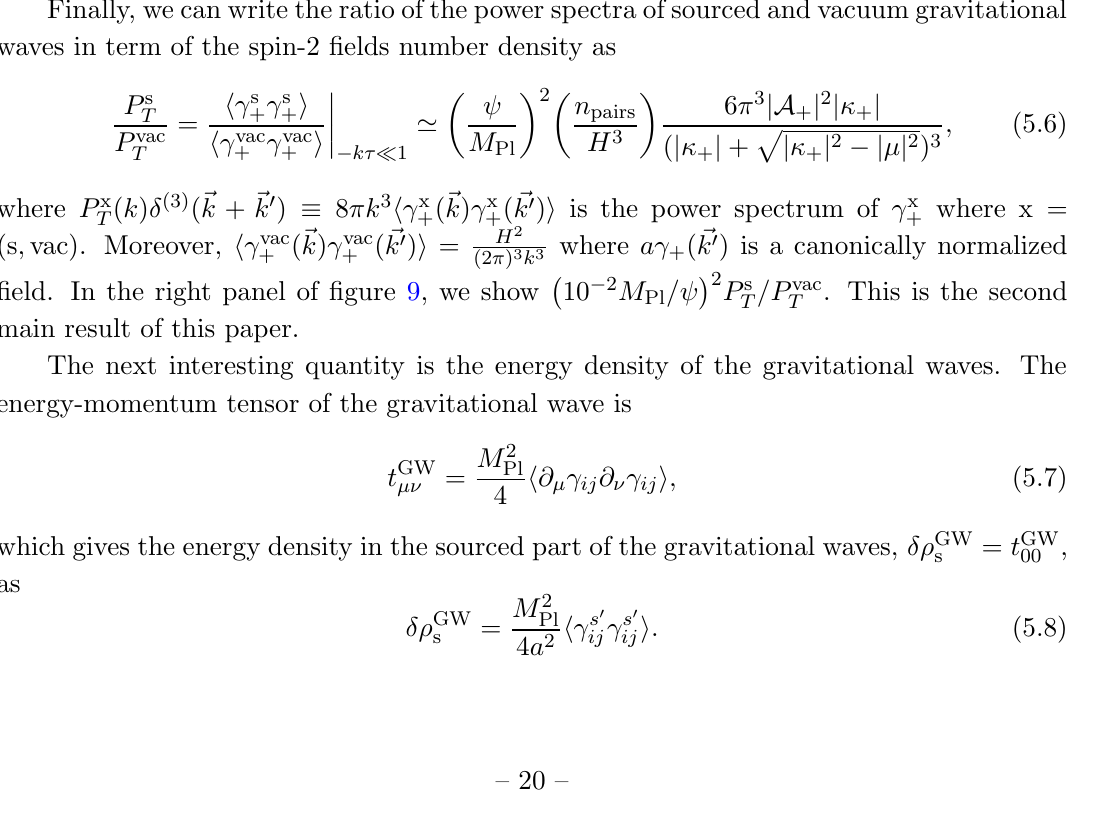
Figure 9 . The energy density (left) and power spectrum (right) of gravitational waves sourced by the gauge (cid:12)eld as a function of (cid:24) A and (cid:24) Z (cid:0) (cid:1) 2 10 (cid:0) 2 M Pl = P s =P vac (right). The dashed line in the right panel shows T T